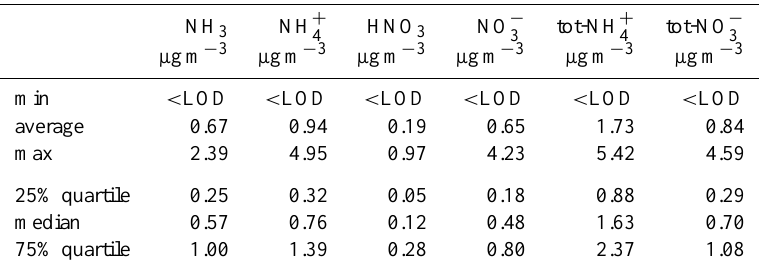
Table 1. : Statistics of NH 3 , NH + , HNO 3 , and NO − concentrations (µgm − 3 , in terms of N) measured from 31 August to 25 September 4 3 2007 at 30.9m (above ground) at the Weidenbrunnen site (LOD: limit of